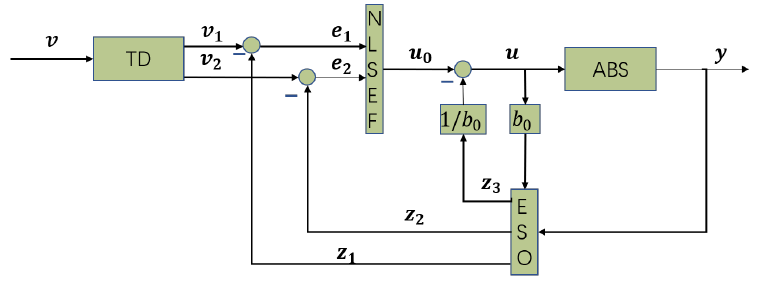
Figure 6. The structure of the